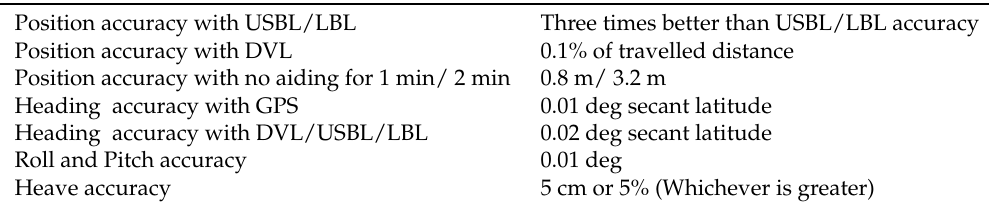
Table 2. The PHINS 6000 INS system technical